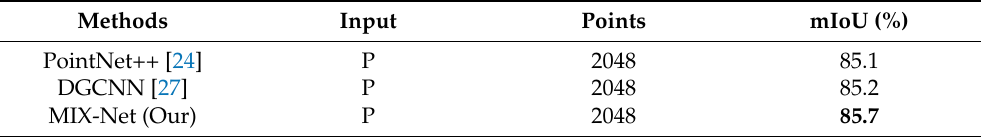
Table 7. Comparison using ShapeNet-Part segmentation dataset. mIoU denotes the average intersec- tion over union. All cited results are taken from the cited papers.